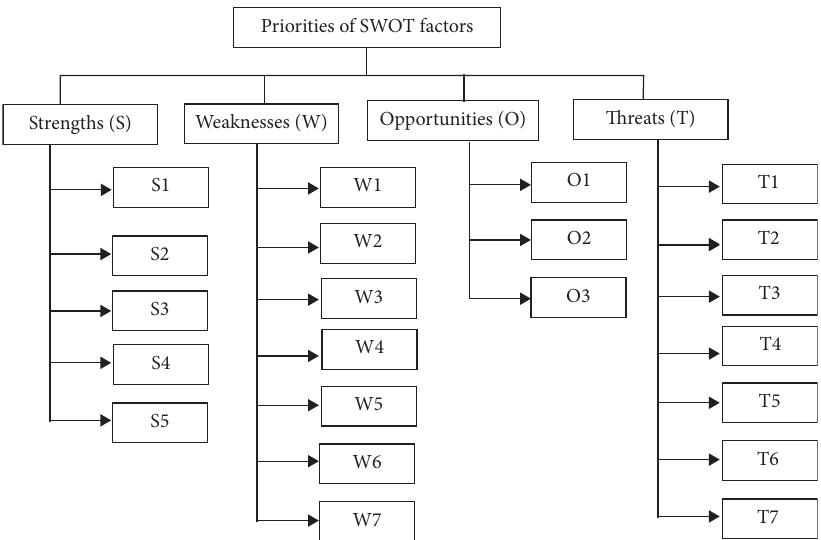
Figure 3: Hierarchical structural of SWOT-AHP. Source: Yang et al., 2009 [46]. Table 4: Pairwise analogy of strengths, weaknesses, opportunities, and threats (SWOT) elements.